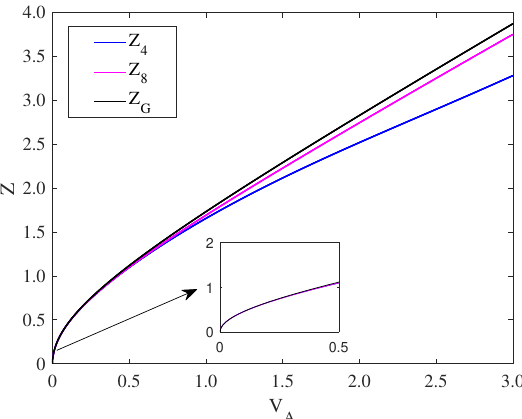
Figure 2. The correlation comparison of Z 4 , Z 8 and Z G